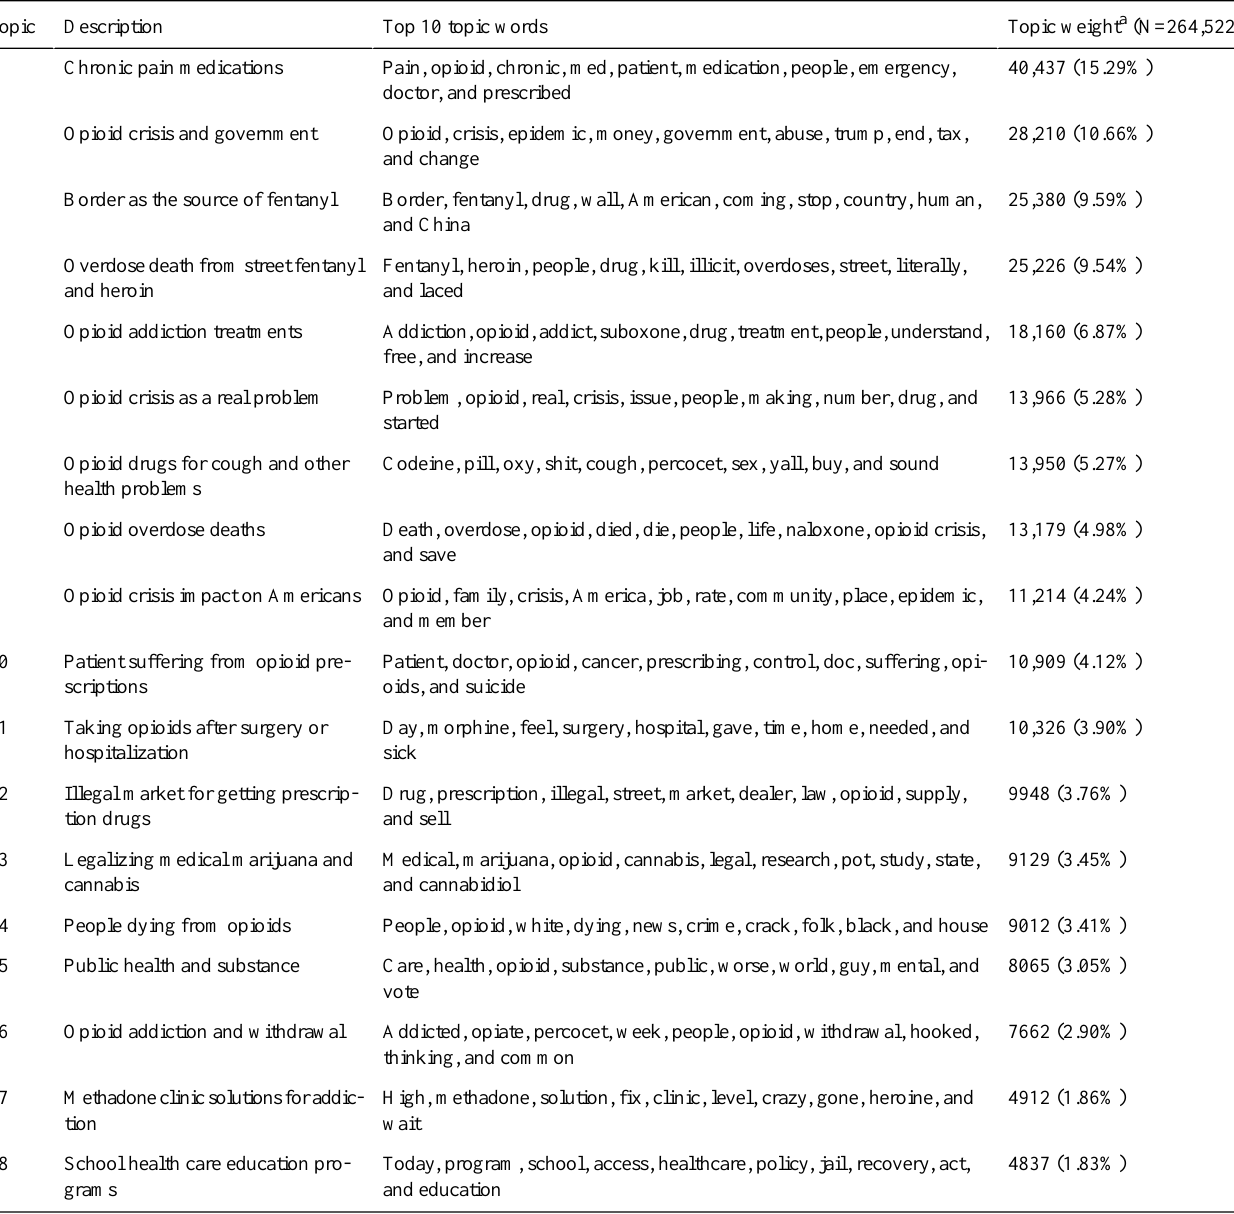
Table 2. Public opioid topic